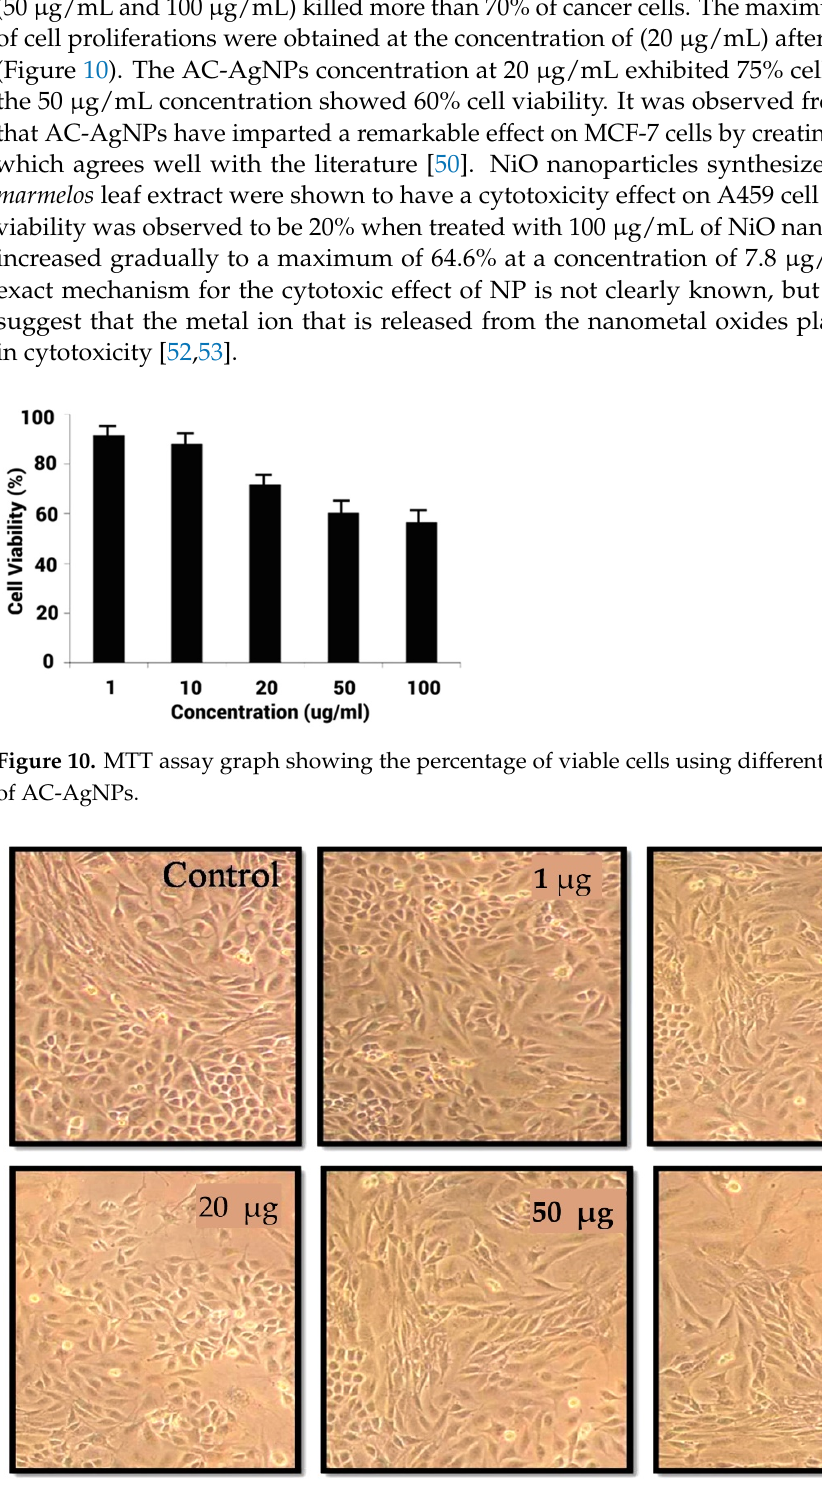
Figure 11. Cytotoxicity assay of different concentrations of AC-AgNPs on MCF—7 cell lines.